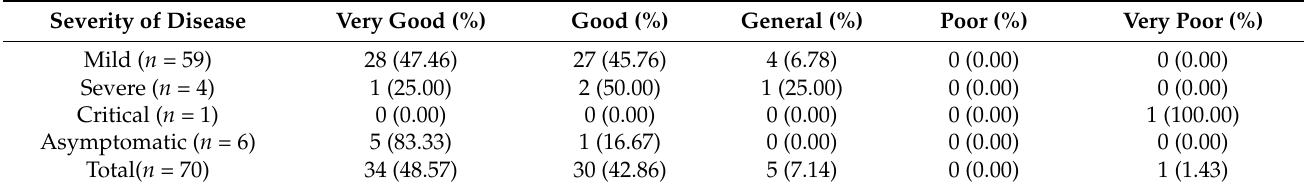
Table 4. Physical conditions of infected students by